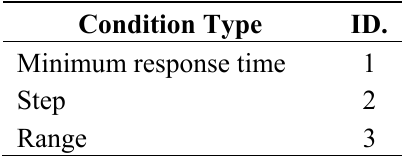
Table 3. Observe Condition types and its